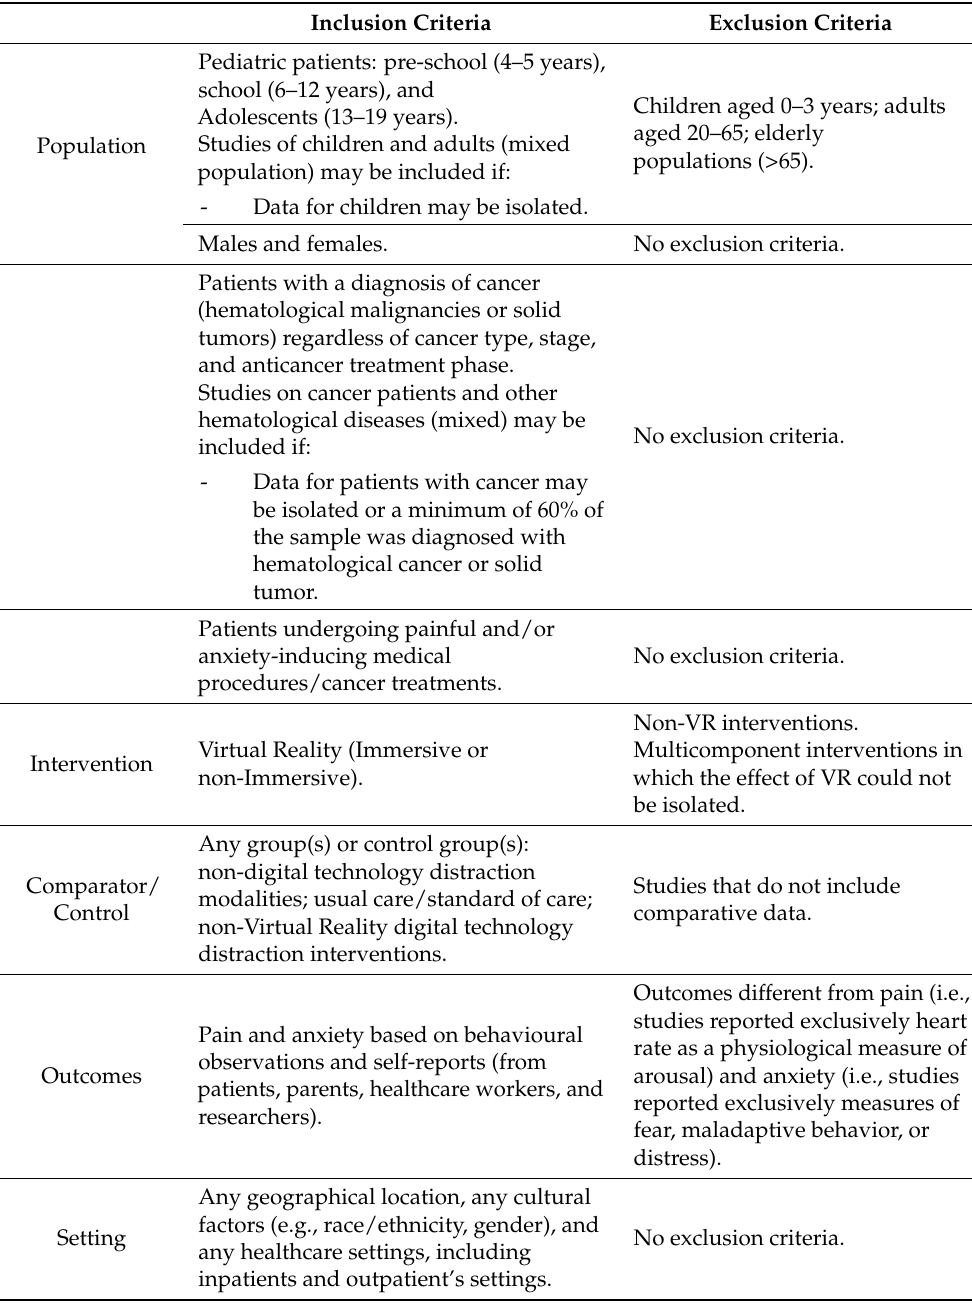
Table 2. Inclusion and exclusion criteria for eligibility in the